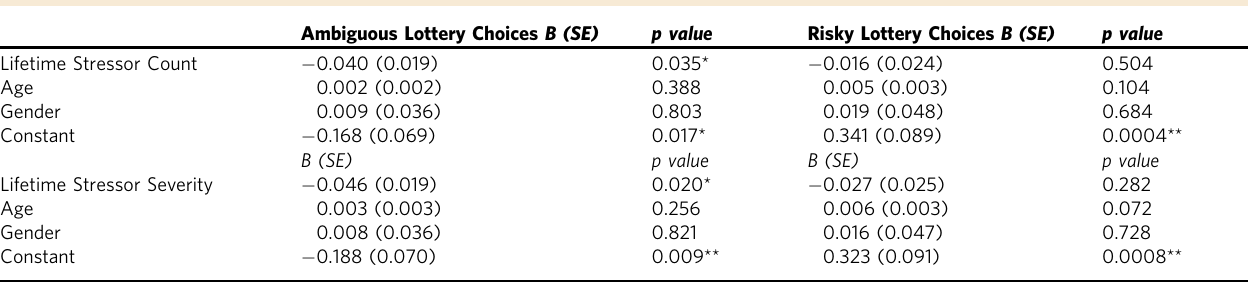
Fig. 4 Multiple regression results for ambiguous lottery choice, lifetime stressor exposure, age, and gender (Study 1). Bars depicting B coef fi cients for proportion of (risk-corrected) ambiguous lottery choices controlling for age and gender. Lifetime stressor count and severity, but not age or gender, were signi fi cant predictors of ambiguous choice behavior. Data shown in bars are expressed as means; errors bars indicate SE. ( N = 58). Table 1 Lifetime stressor exposure and ambiguous vs. risky lottery choice (Study 1).